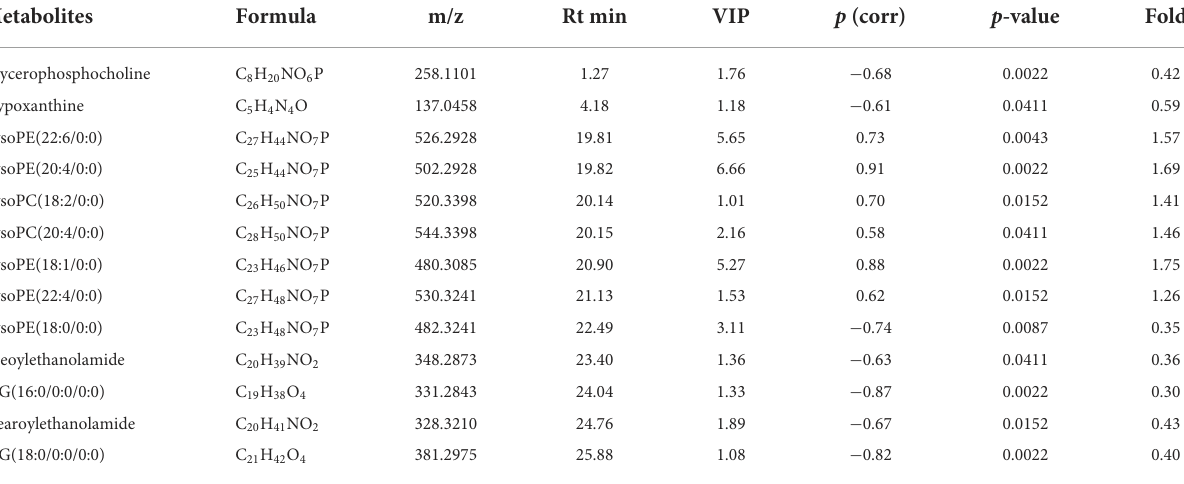
TABLE 3 Basic information of differential metabolites in Low-dose vs.